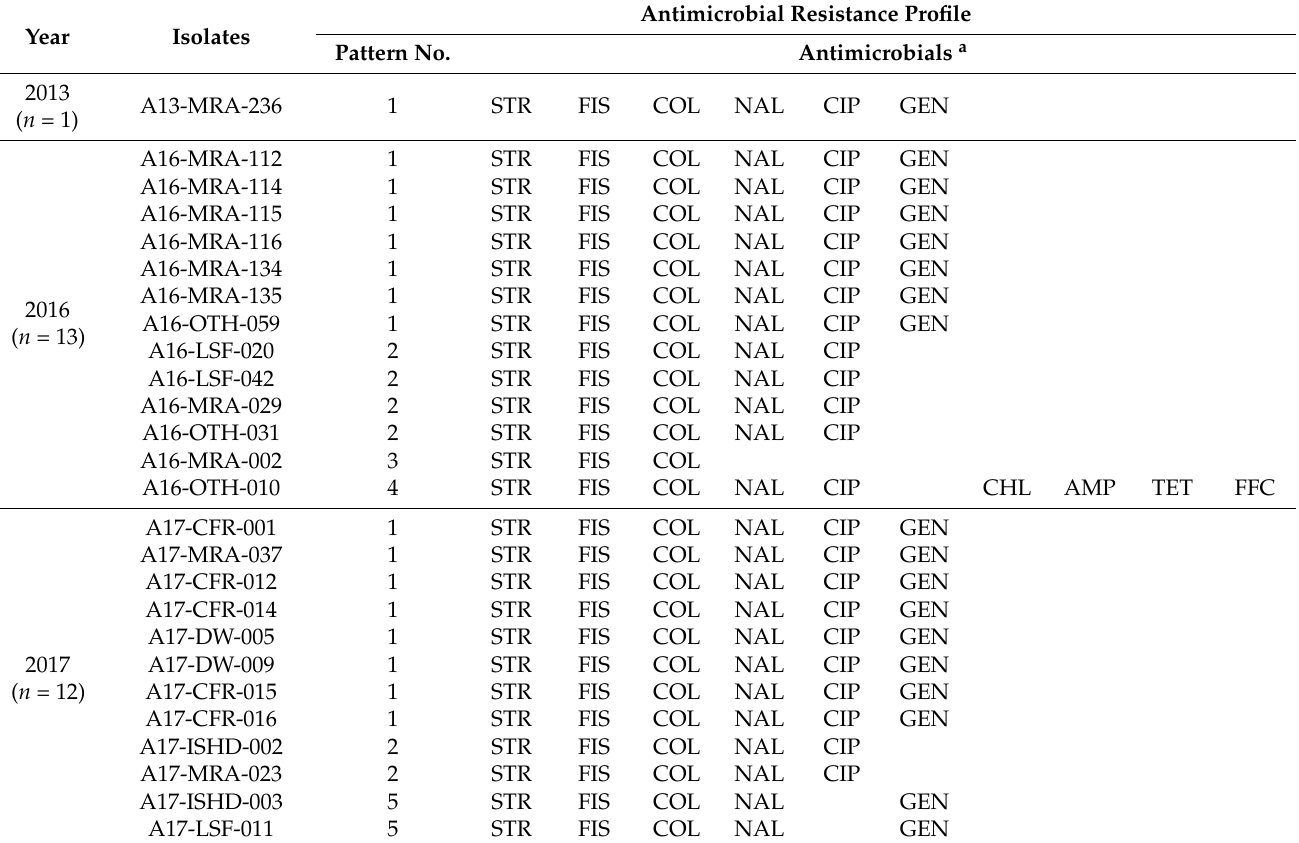
Table 2. Antimicrobial resistance patterns of S. enterica ser. Gallinarum isolates ( n = 30). Antimicrobial Resistance Profile Year Isolates Pattern